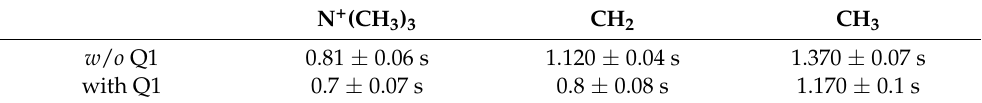
Table 1. Spin-lattice (T 1 ) relaxation times of lipids in the absence and in the presence of 1 mM Q1.